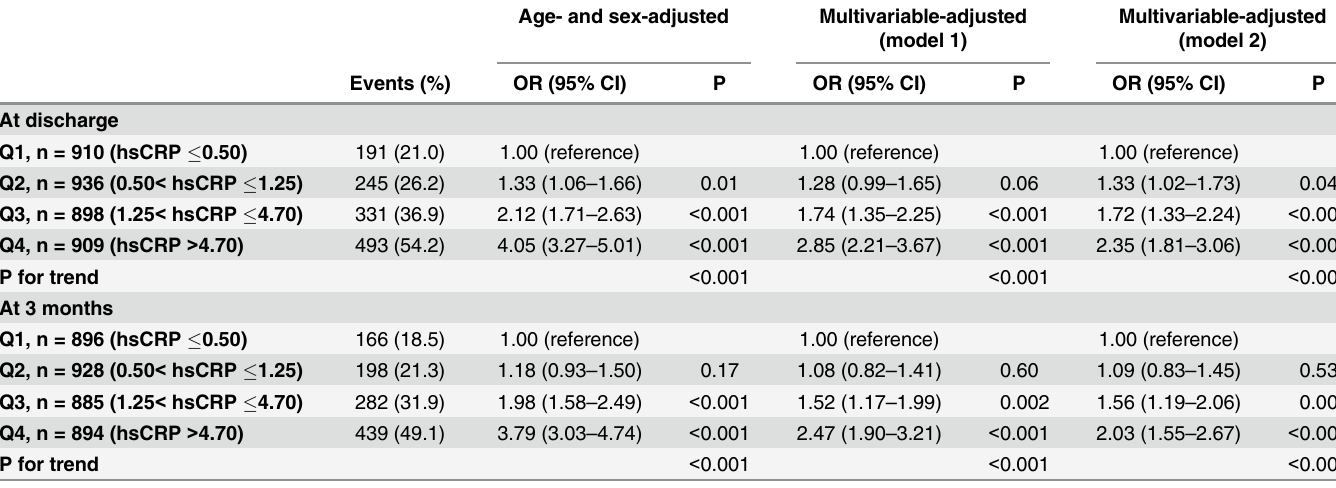
Table 4. Plasma hsCRP levels and poor functional outcome at discharge and at 3 months. Age- and